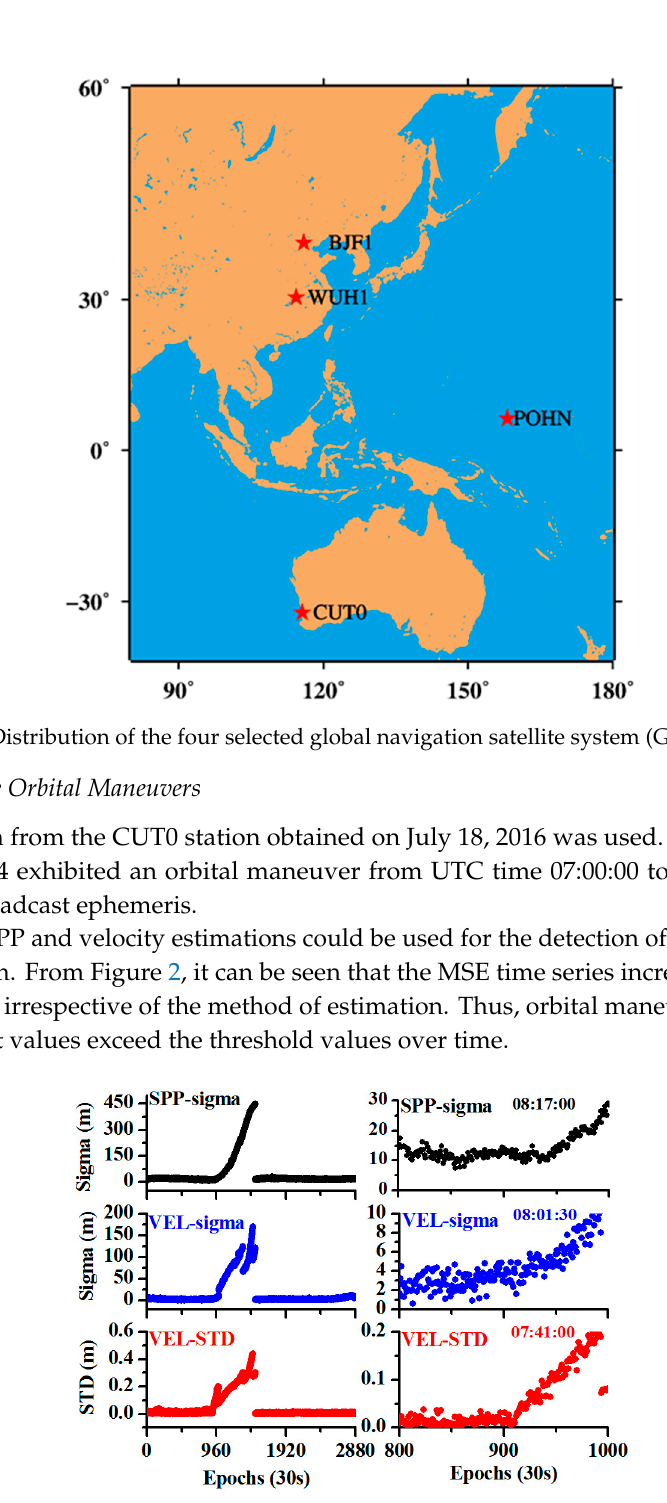
Table 1. Details of the four selected GNSS stations.